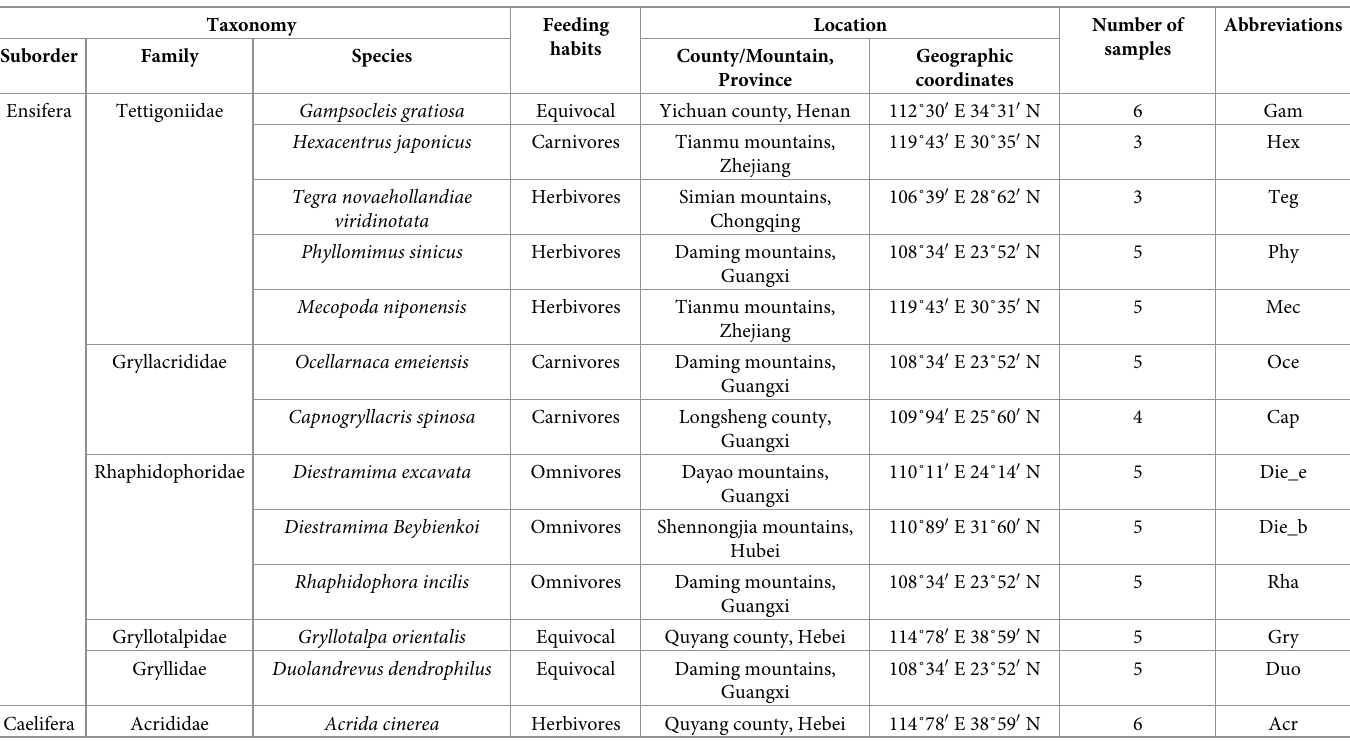
Table 1. Sampling